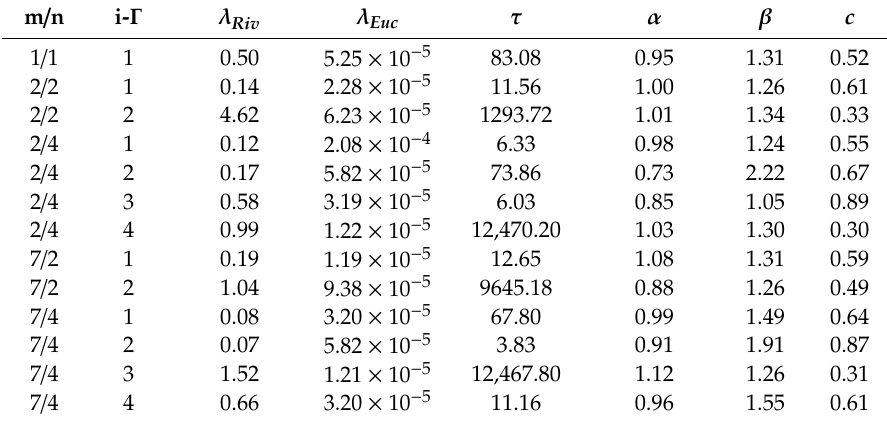
Table A2. Resulting model parameters for the distance kernels Γ i .